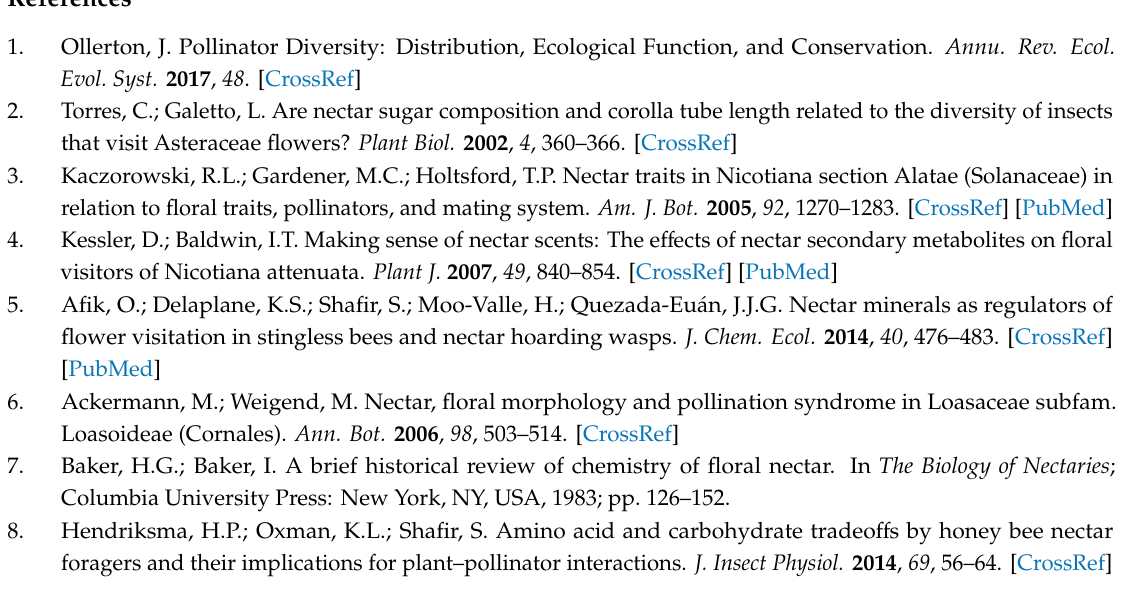
Table S1: Metabolite concentrations, Table S2: Summary Nicotiana floral nectar sugars and amino acids, Table S3: Hierarchical agglomerative clustering of Nicotiana nectar metabolomes by section, Table S4: Hierarchical agglomerative clustering of Nicotiana nectar metabolomes by pollinator. These supplemental files